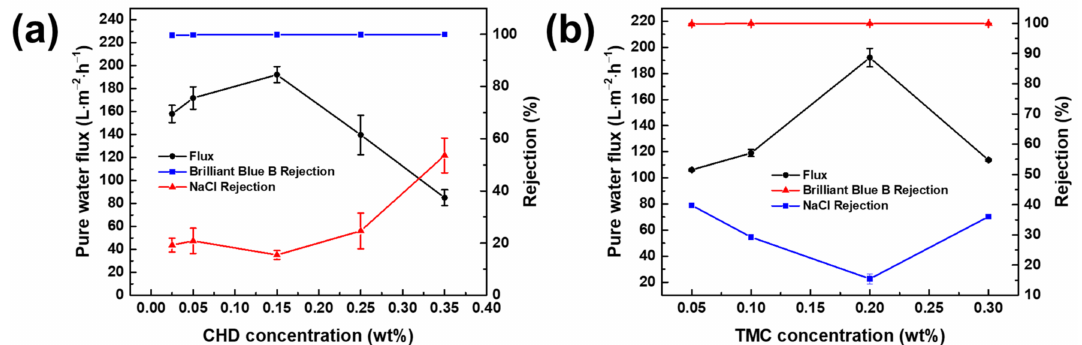
Figure 6. Effect of ( a ) CHD concentration and ( b ) TMC concentration on the performance of the TFC CHD